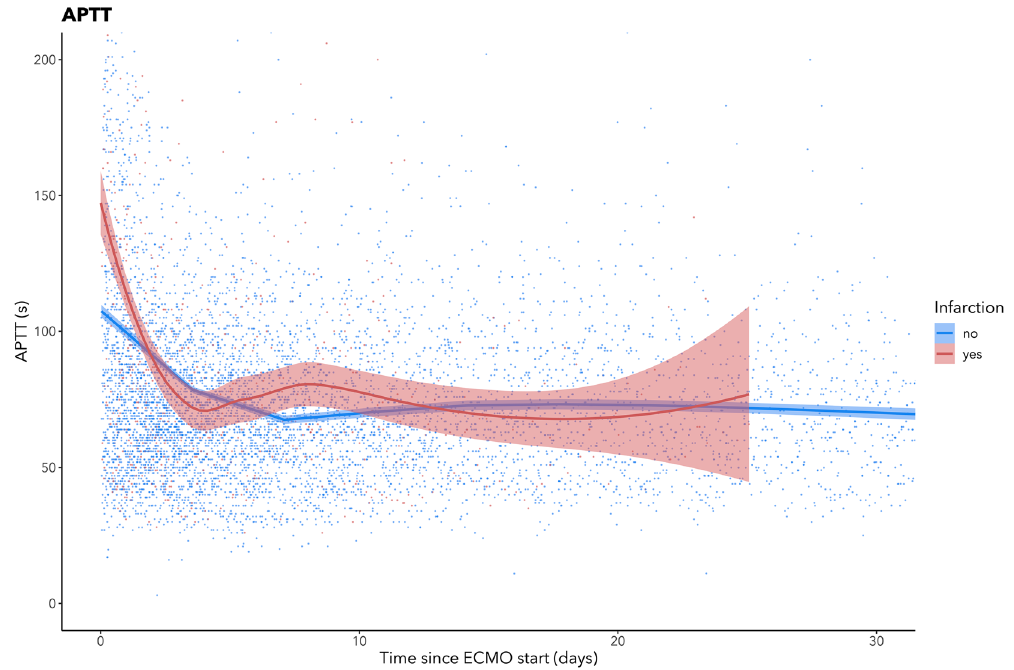
Figure 4. Scatterplot of activated partial thromboplastin time (APTT) depicted longitudinally and subdivided according to brain infarction status. Samples were collected during the first month of treatment or until BI detection. The red line represents patients that suffered brain infarction on ECMO, the blue line represents patients with no signs of infarction. The line indicates a LOWESS curve and the shaded area surrounding it indicates 95% confidence intervals. The graph was created using ggplot 2 (Wickham H. ggplot2: Elegant Graphics for Data Analysis, 2016. NY: